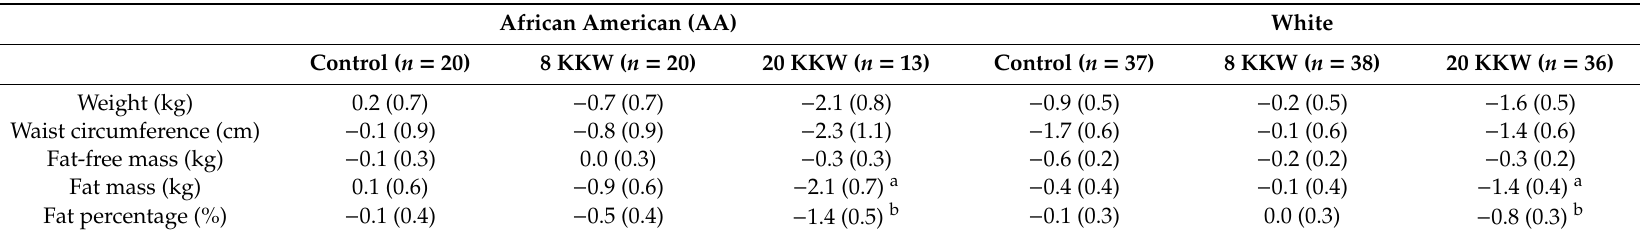
Table 3. Changes in anthropometric and body composition measures in response to the 24-week intervention in Africans Americans and Whites. African American (AA) White Control ( n =